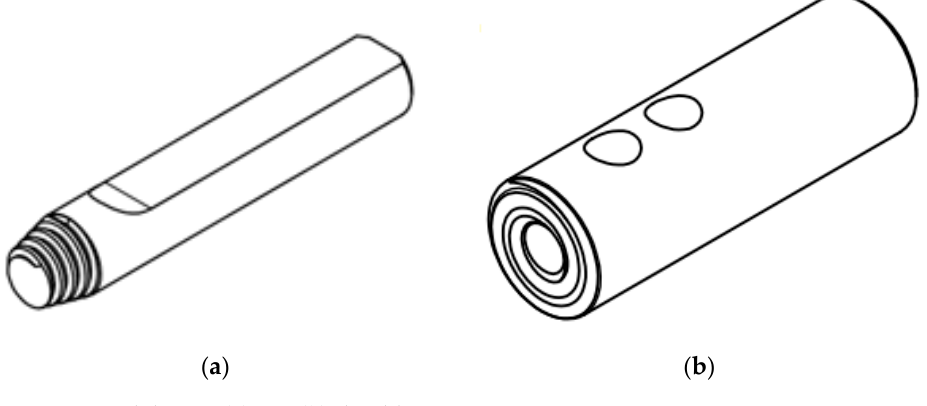
Table 4. Proposed dimensions for a tool using the suggested guidelines.